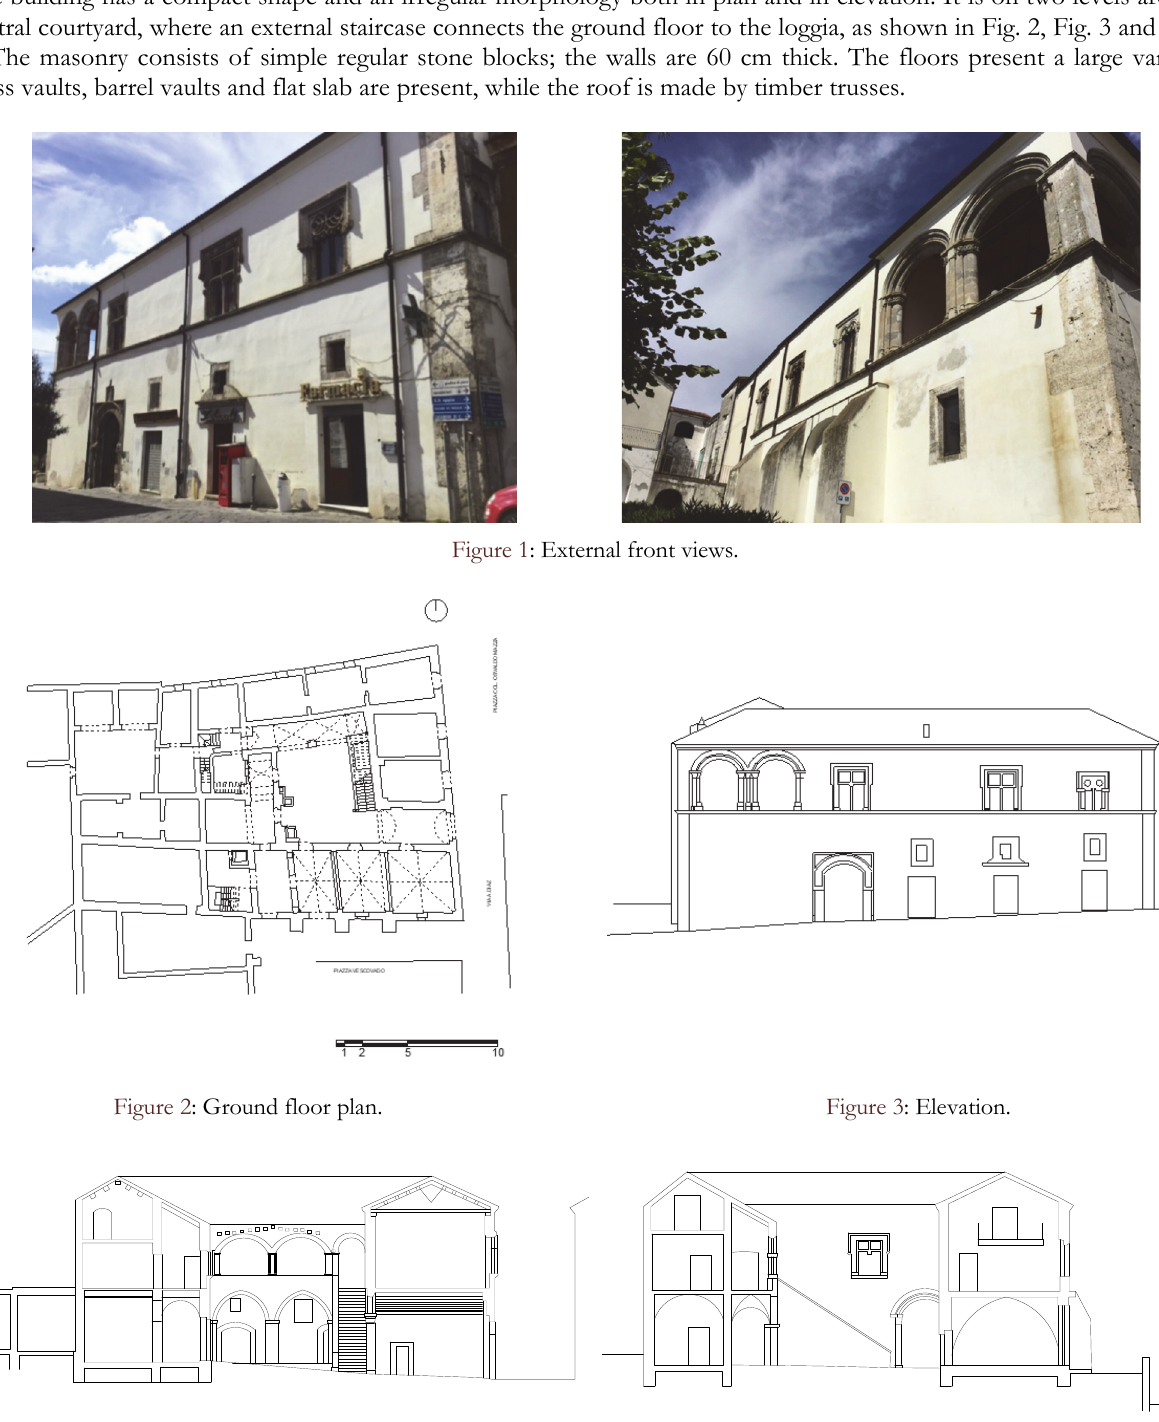
Figure 4: Sections